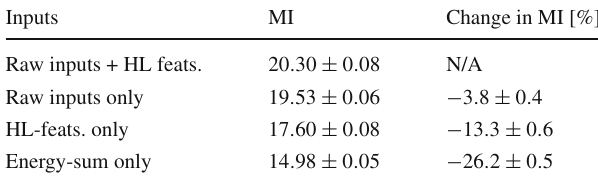
Table 1 Mean Improvements for a range of different input configura- tions. The MI is computed on the monitoring-validation data and aver- aged over the training of five models per configuration. The change in MIiscomputedasthedifferencebetweenconfigurationandthenominal model (“Raw inputs + HL feats.”) as a fraction of the MI of the nominal model. Energy-sum features are the three features corresponding to the sums of energy in different threshold regions (V[0], V[26], and V[27]) Inputs MI Change in MI [%] Raw inputs + HL